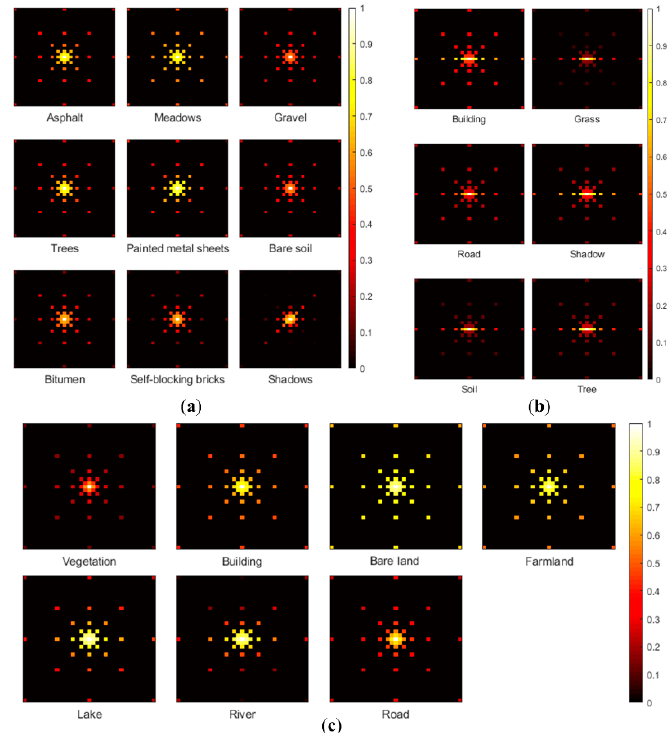
Figure 9. Spatial correlation in the form of spatial covariance derived from MLC classification results: ( a ) The ROSIS image, ( b ) the IKONOS image, and ( c ) the Landsat